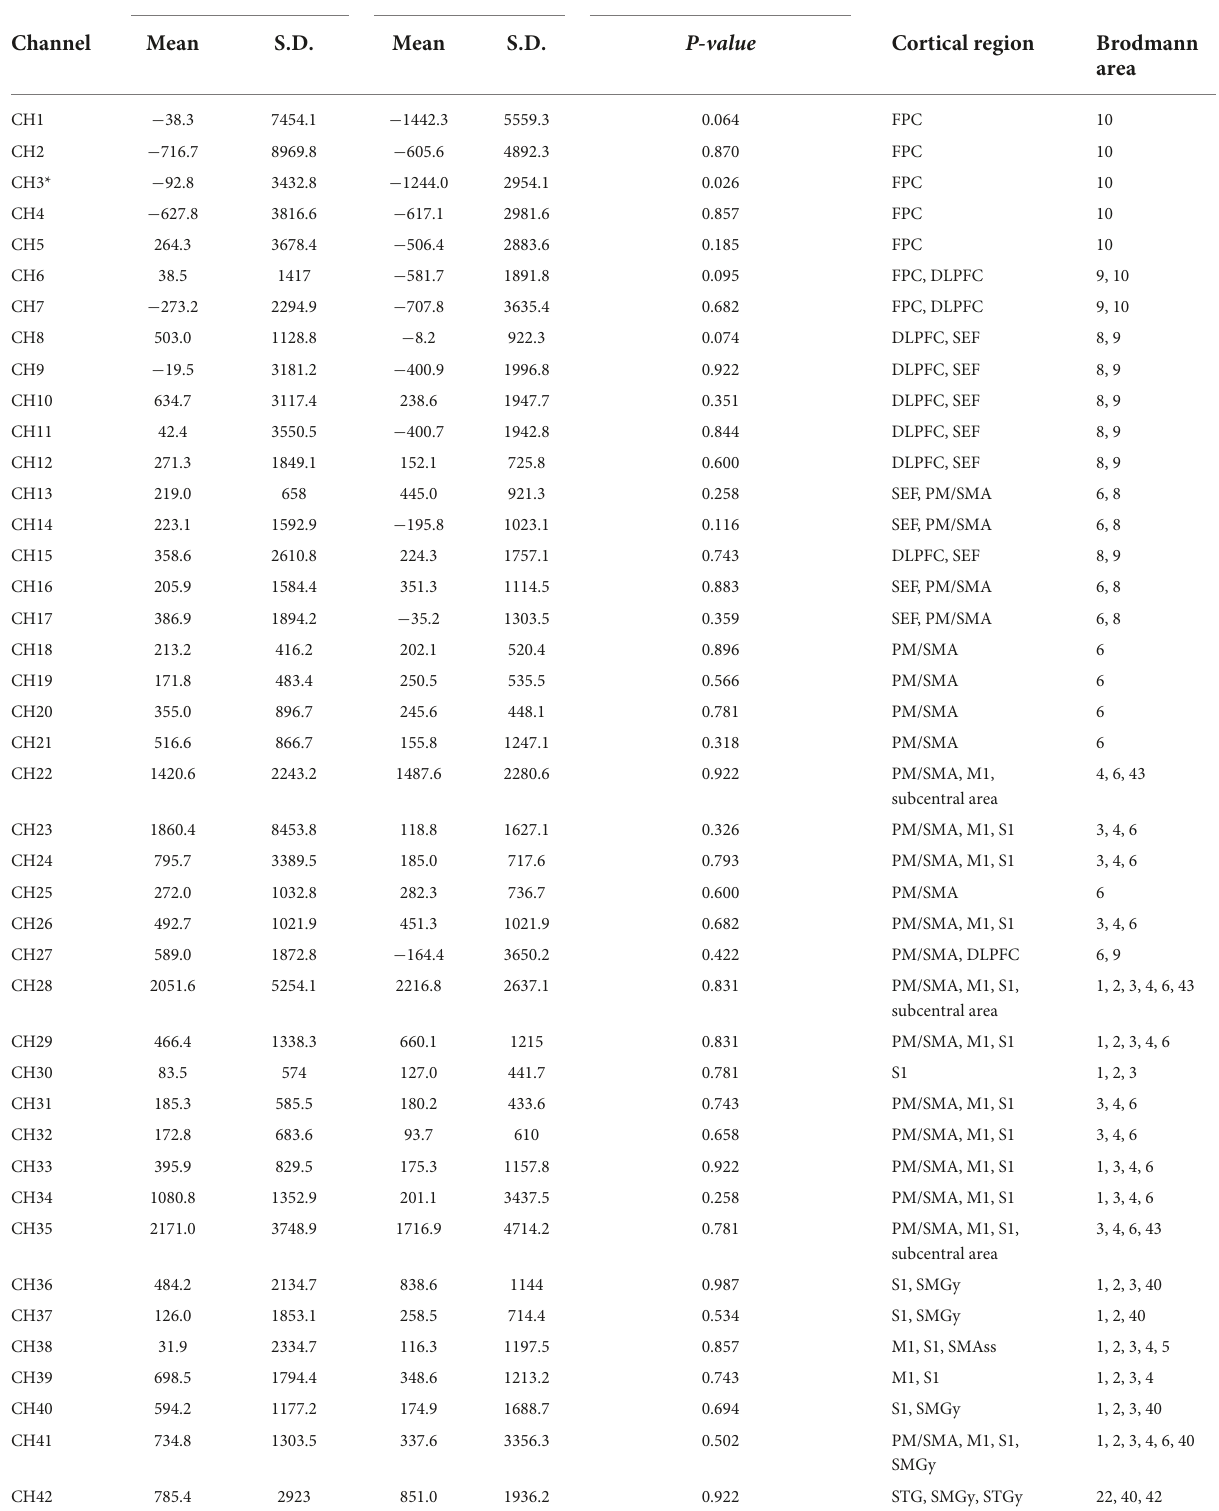
TABLE 1 Comparison of the hemodynamic responses during the chewing of palatable gum and unpalatable gum and comparison of the area under the curves (AUCs) during gum